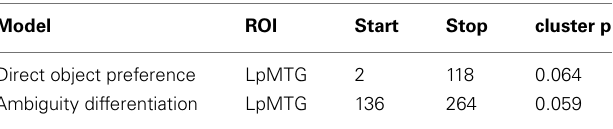
Table 2 | RSA results from the onset of the second word in the central